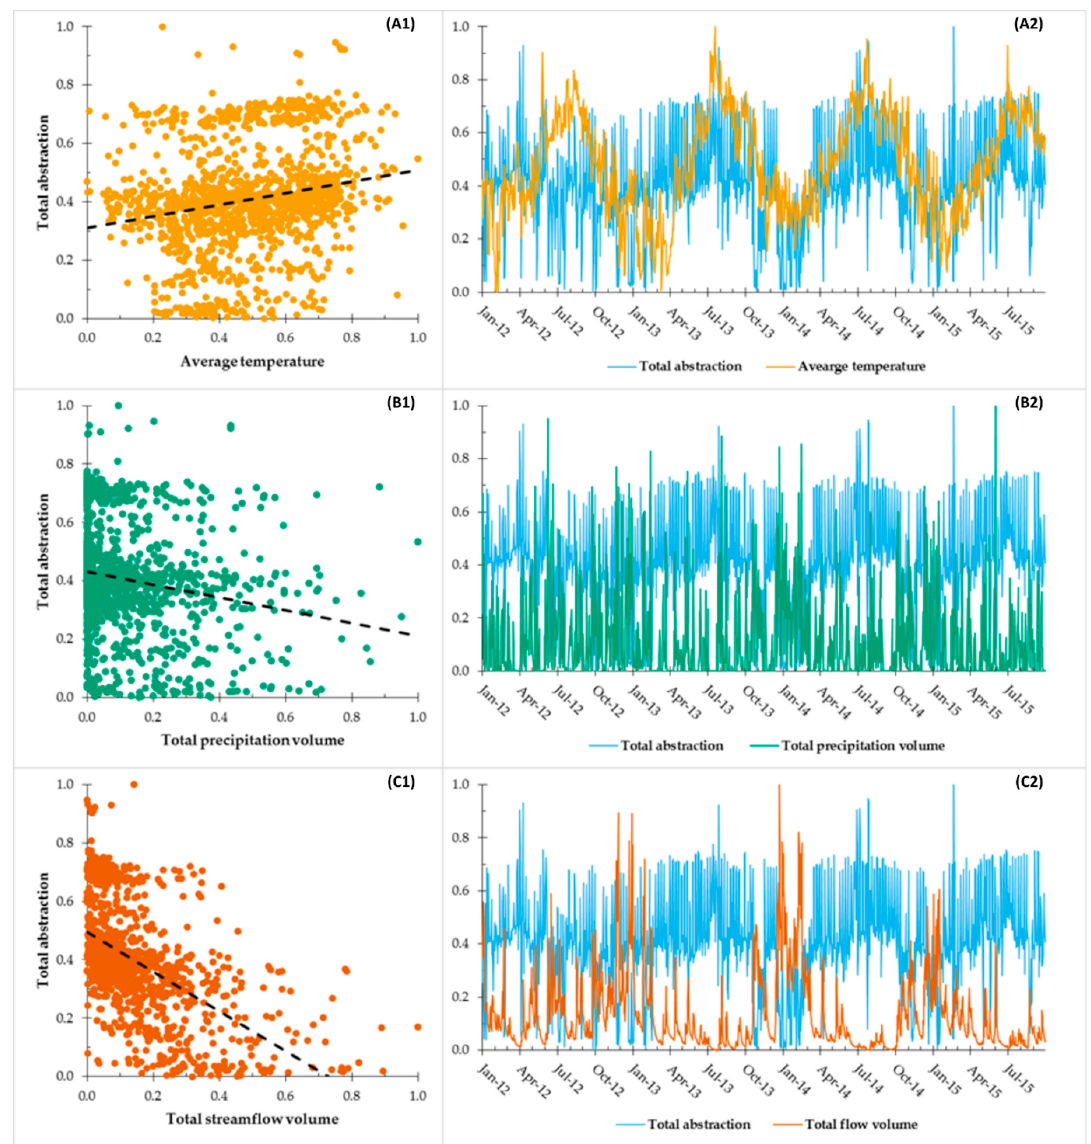
Figure 6. Normalized daily hydroclimatic data compared with normalized daily abstraction data for the period 1 January 2012 to 30 September 2015, for all study catchments combined. ( A1 , B1 , C1 ) Paired comparison, with black dashed lines representing trend direction; ( A2 , B2 , C2 ) time series comparison. Combined data is based on an average across all catchments for temperature, while precipitation, streamflow and abstraction volumes are all total volumes summed from all catchments.